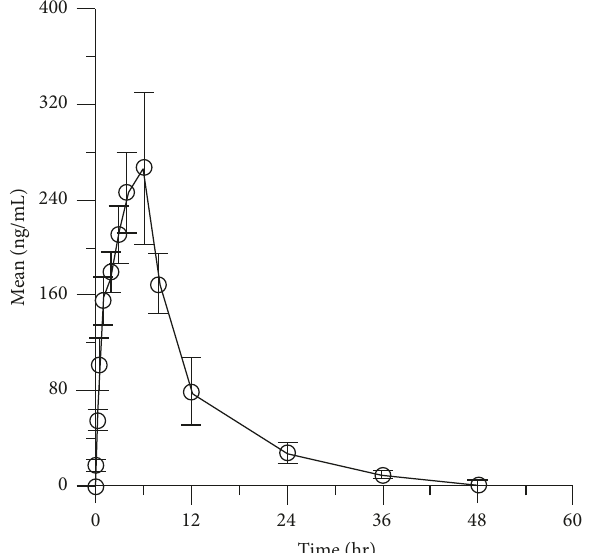
Figure 2: Concentration-time curve of icaritin in rat plasma after oral administration.